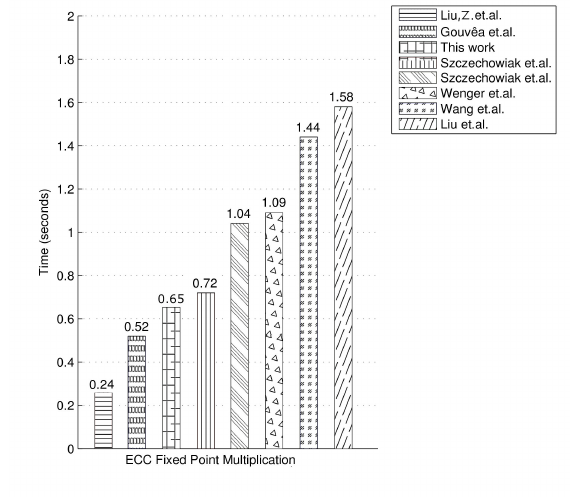
Figure 2. Comparison for fixed point multiplication